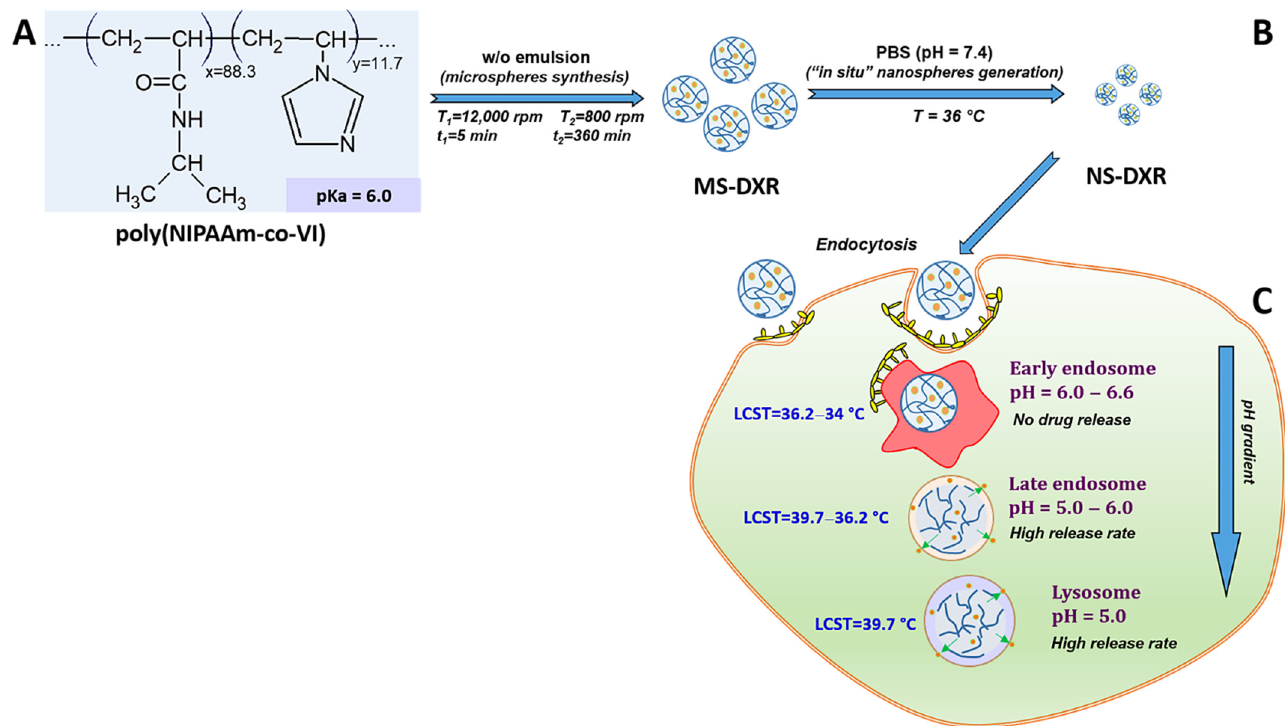
Figure 7. Schematic representation of the potential behavior of DXR-loaded microspheres (MS-DXR) made of poly(N-isopropylacrylamide-co-vinylimidazole) copolymer after suspension in physiological buffers and interaction with a tumor cell. The synthesized MS-DXR ( A ) disintegrate in monodisperse stable nanoparticles (NS-DXR) in conditions simulating the bloodstream (PBS, pH = 7.4, T = 36 °C) ( B ), that are internalized by the cancer cells by endocytosis ( C ). After internalization, the NS-DXR arrives in the late endosomes (pH: 6.0–5.0), where they start to disintegrate and release the drug cargo.